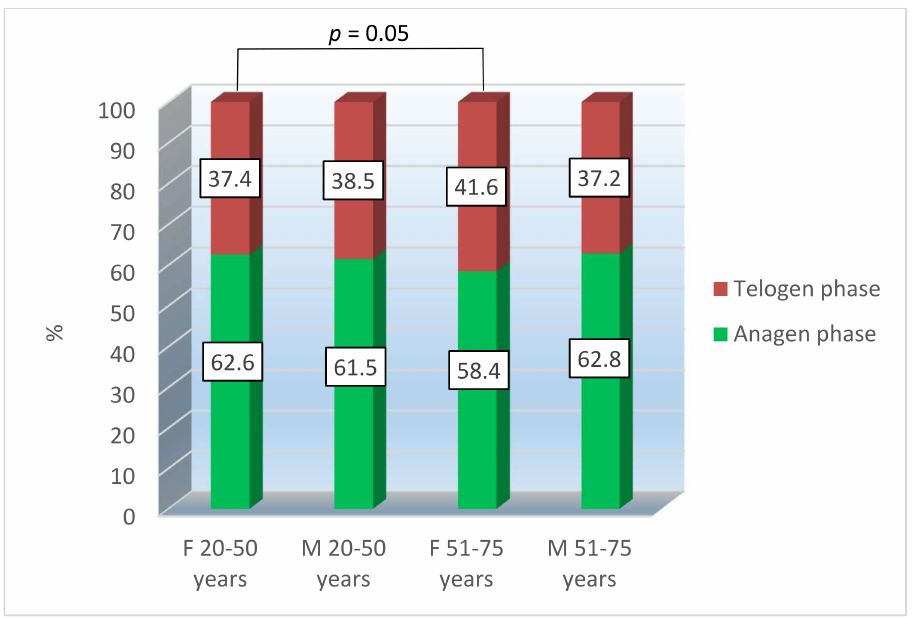
Figure 7. Mean basal values of the percentage of hair in anagen/telogen phase as a function of age group and gender.